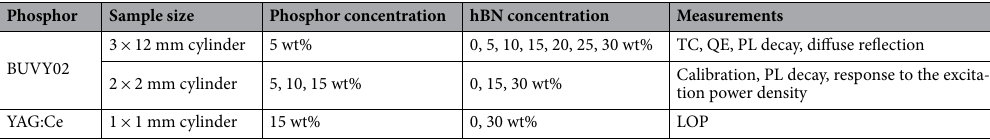
Table 1. Dimensions and composition of the samples, as well as the performed